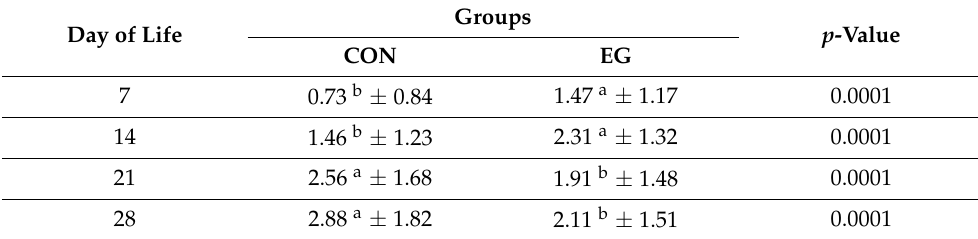
Table 8. Footpad dermatitis score of broilers ( n = 250) from d 7 to d 28 (mean ± SD). Day of